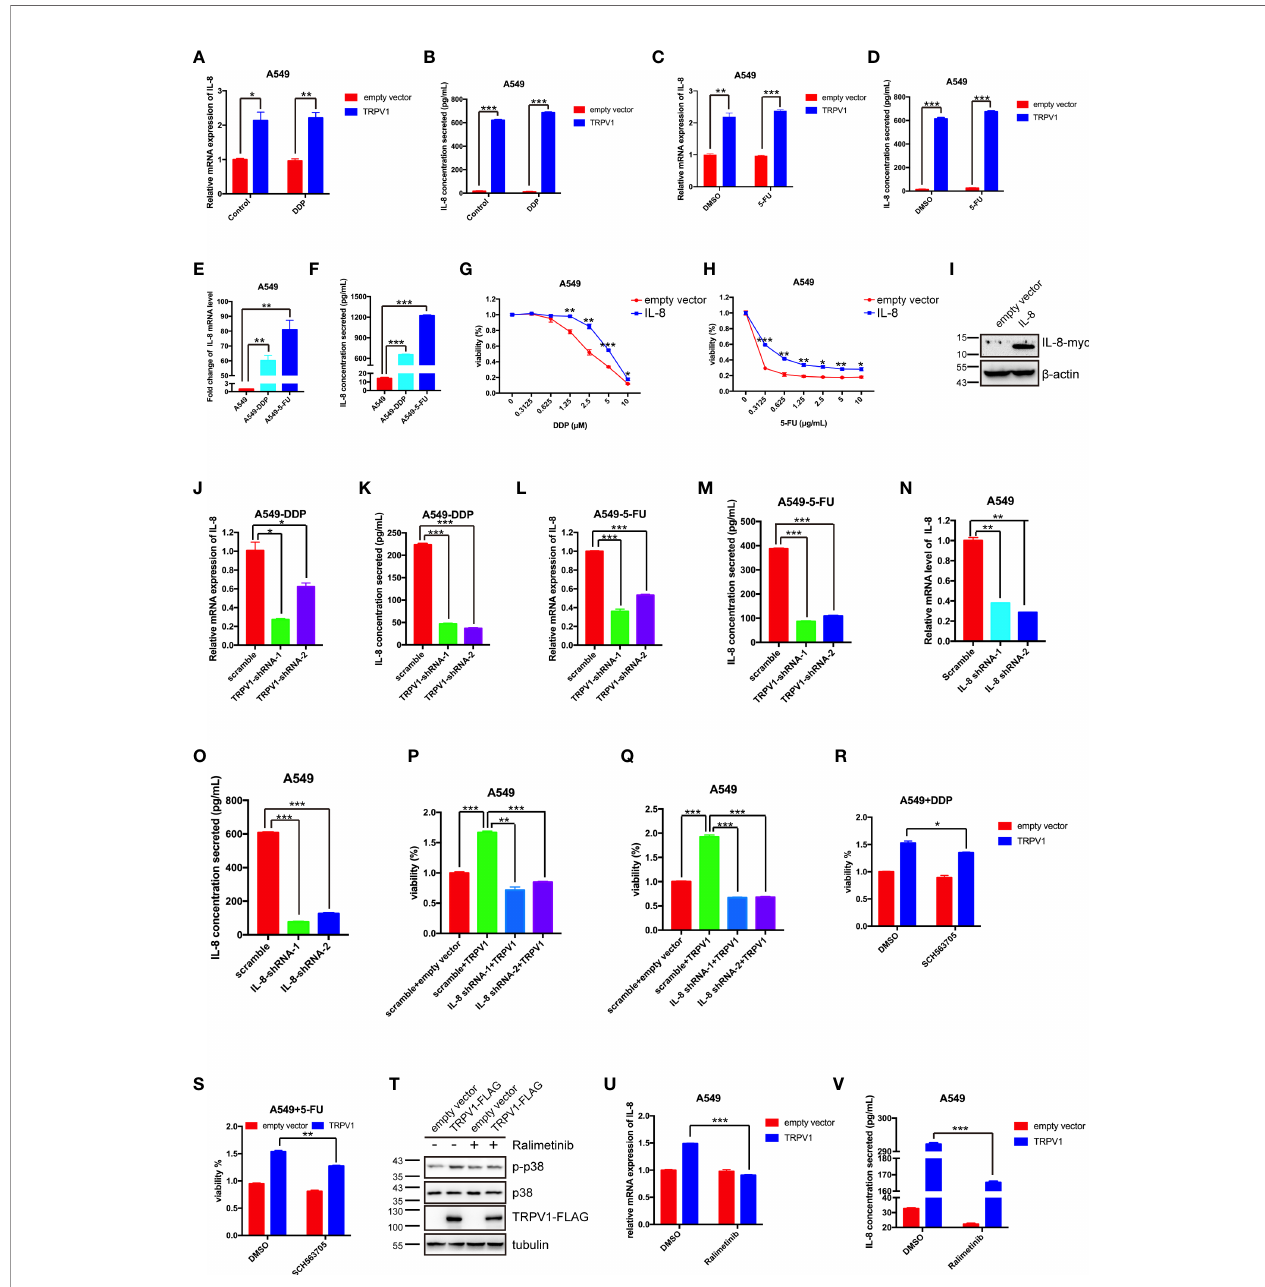
FIGURE 8 | TRPV1 overexpression induced DDP and 5-FU resistance through upregulation of IL-8 expression. (A-D) Quantitative PCR and ELISA analysis showing that TRPV1 overexpression increased IL-8 mRNA expression and secretion with or without DDP treatment (1 m M) or 5-FU treatment (0.5 m g/mL) for 24 h. (E, F) Quantitative PCR and ELISA analysis showing that IL-8 mRNA expression and secretion were increased in A549-DDP and A549-5-FU resistant cells. (G, H) CCK-8 assay showing that IL-8 overexpression decreased DDP and 5-FU sensitivity in A549 cells. (I) Western blot analysis showing IL-8 overexpression in A549 cells; b -actin served as the loading control. (J – M) Quantitative PCR and ELISA analysis showing that IL-8 mRNA expression and secretion were decreased in A549-DDP and A549-5-FU resistant cells after TRPV1 knockdown. (N, O) Quantitative PCR and ELISA analysis of IL-8 knockdown ef fi ciency in A549 cells. (P, Q) CCK-8 assay showing that IL-8 knockdown reversed DDP and 5-FU resistance induced by TRPV1 overexpression. Cells were treated with DDP (2.5 m M) or 5-FU (0.625 m g/mL) for 72 h. (R, S) CCK-8 assay showing that inhibition of IL-8 receptors partially reversed DDP and 5-FU resistance induced by TRPV1 overexpression. Cells were treated with DDP (1.25 m M)/5-FU (0.3125 m g/mL) and SCH563705 (20 m M) for 72 h. (T) Western blot analysis showing that TRPV1 overexpression caused p38 activation. Cells were treated with ralimetinib (0.5 m M) for 24 h. (U, V) Quantitative PCR and ELISA analysis showing that the upregulation of IL-8 mRNA expression and secretion level mediated by TRPV1 overexpression were reduced by treatment with ralimetinib (0.5 m M) for 24h. Three independent experiments were performed. Statistical signi fi cance was determined using Student ’ s t test. Data represent mean ± SEM; * P < 0.05. ** P < 0.01. *** P <